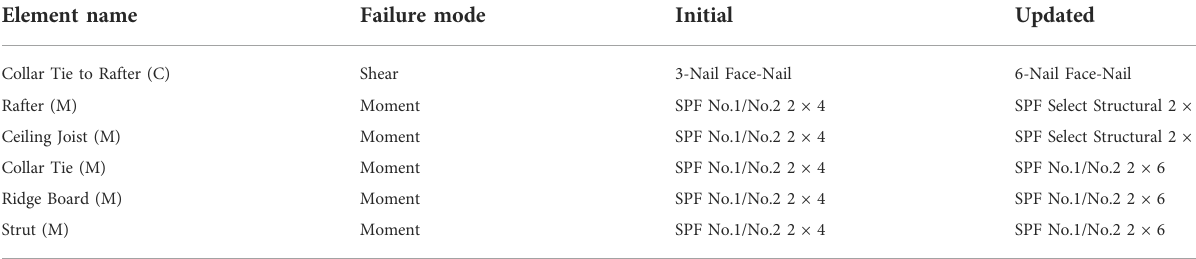
TABLE 5 All of the updated connections (C) and members (M) due to wind loading in order of failure.